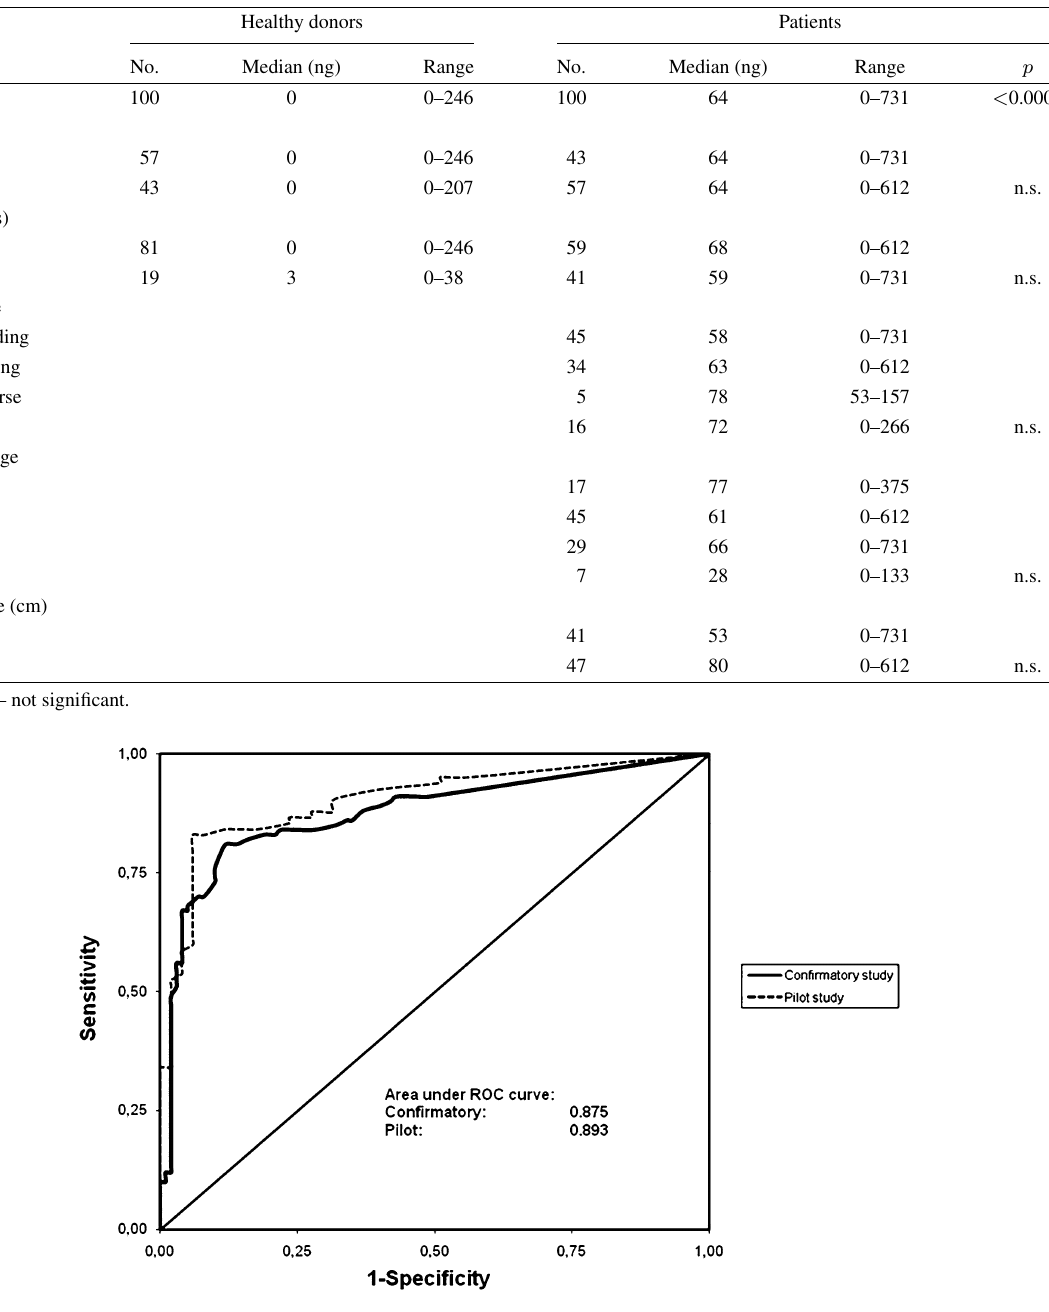
The results reported by different studies on the diag- nostic accuracy of fecal DNA are not consistent, prob- ably due to the different methodologies used [6,20,25]